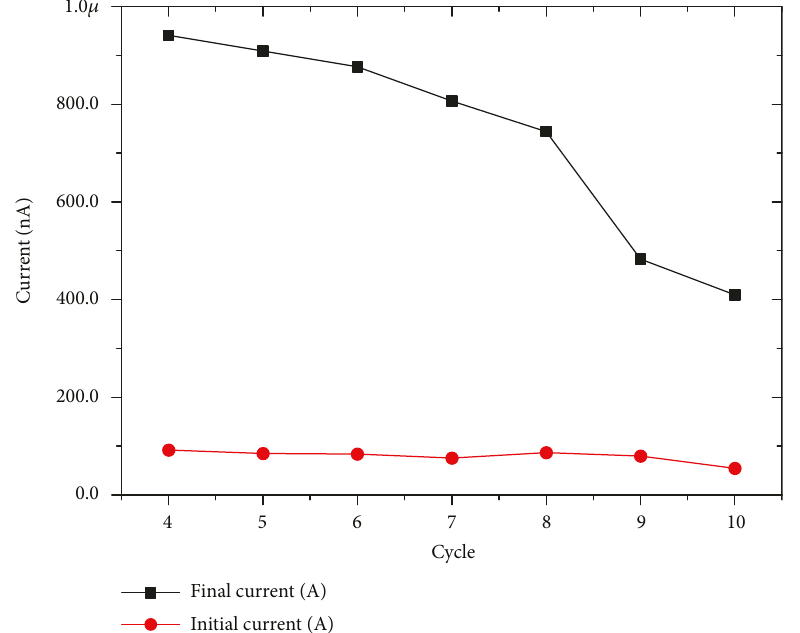
Figure 7: Final and initial current values of the Memristor system ’ s responses reported in Figure 6 for a progressive lowering of chloride ion content in the